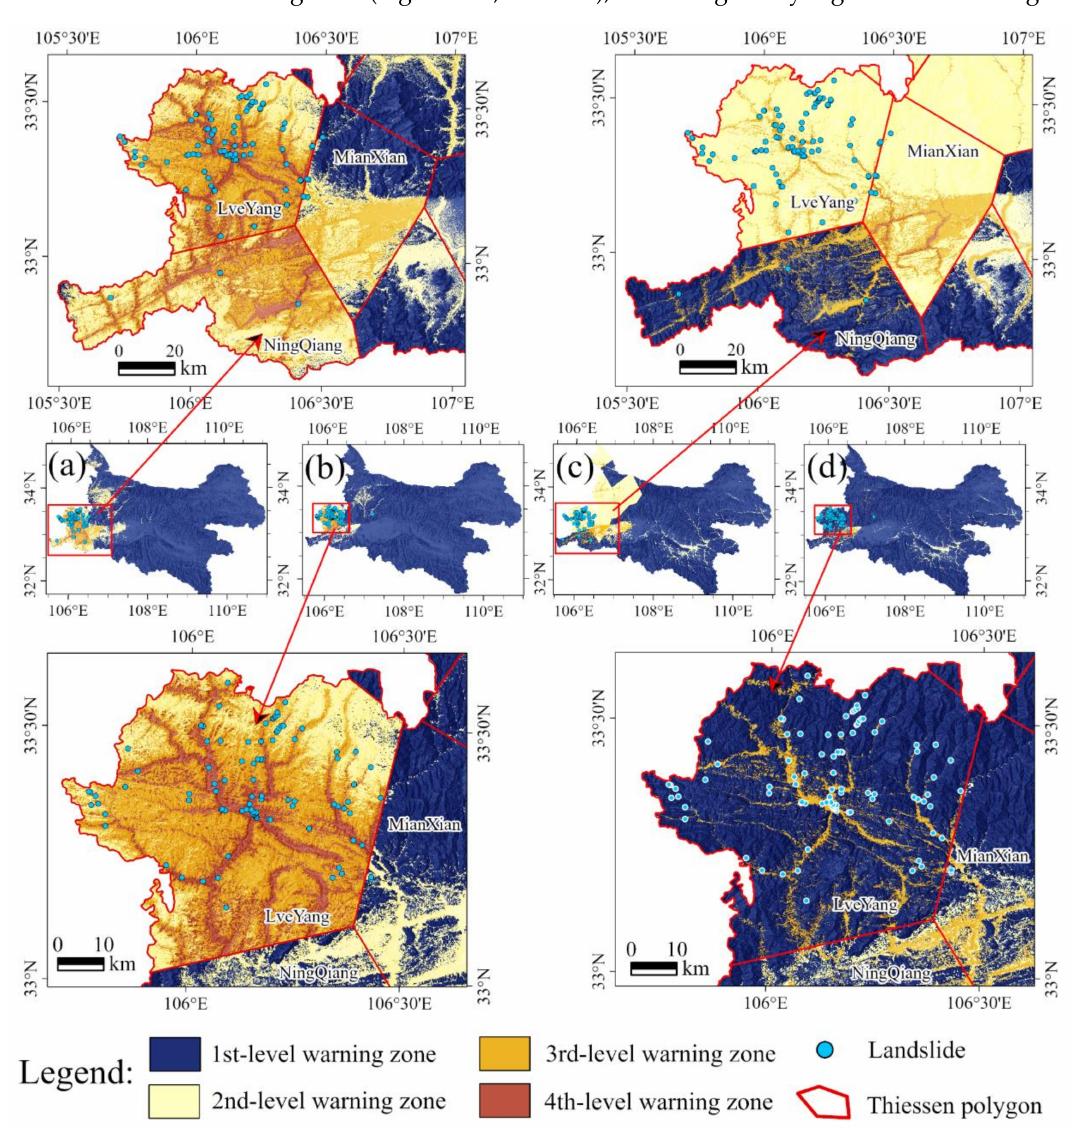
Figure 17. Simulated warning results of the PLEWM and DLEWM for two long-term and high- intensity rainfall events: ( a ) using the PLEWM on 11 July ( b ) using the PLEWM on 14 July ( c ) using the DLEWM on 11 July and ( d ) using the DLEWM on 14